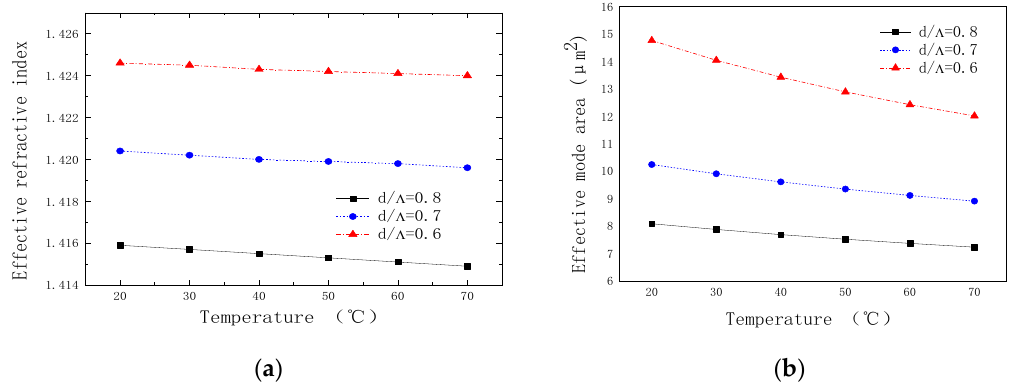
Figure 5. ( a ) the effective refractive index and ( b ) the effective mode area vary with temperature.